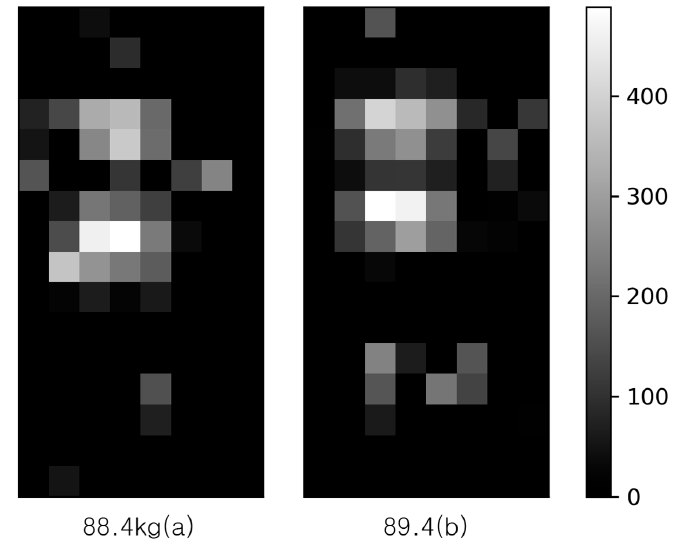
Figure 10. Visualization of the samples using the average sensed value.